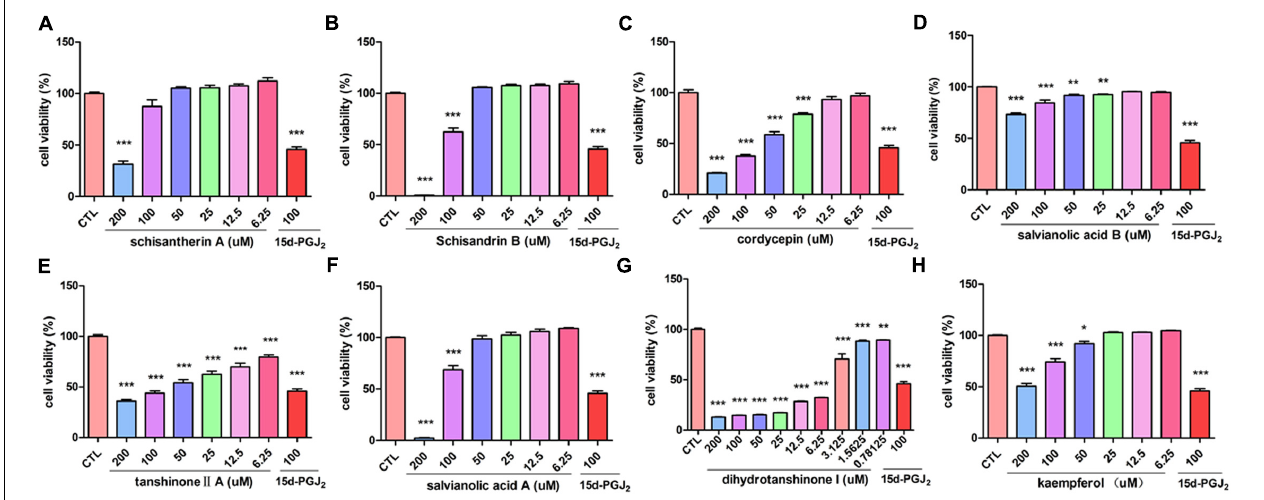
FIGURE 7 | Active components of FZHY formula inhibited the activation of rat HSC-T6 cells. T6 cells were treated for 24 h in the presence of indicated concentrations of (A) schisantherin A, (B) schisandrin B, (C) cordycepin, (D) salvianolic acid B, (E) tanshinone II-A, (F) salvianolic acid A, (G) dihydrotanshinone I, (H) kaempferol, and the cell viability was measured with CCK8 assay. Data were obtained from three independent experiments performed in triplicate and presented as means ( ± SD). ∗ P < 0.05, ∗∗ P < 0.01, ∗∗∗ P < 0.001, compared with the control